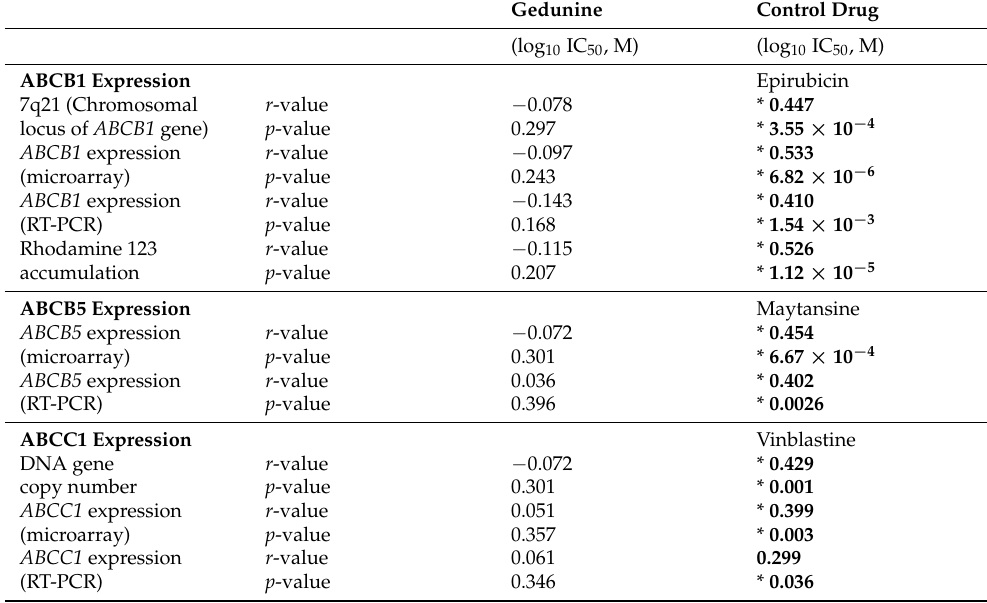
Table 5. Correlation of the log 10 IC 50 values for gedunin to ABC-transporter-mediated mechanisms of multidrug resistance (P-glycoprotein/ABCB1, ABCB5, ABCC1, and ABCG2) and other mechanisms of anticancer drug resistance (EGFR, RAS, TP53, WT1, HSP90, GST π , and the proliferative rate) in the NCI panel of tumor cell